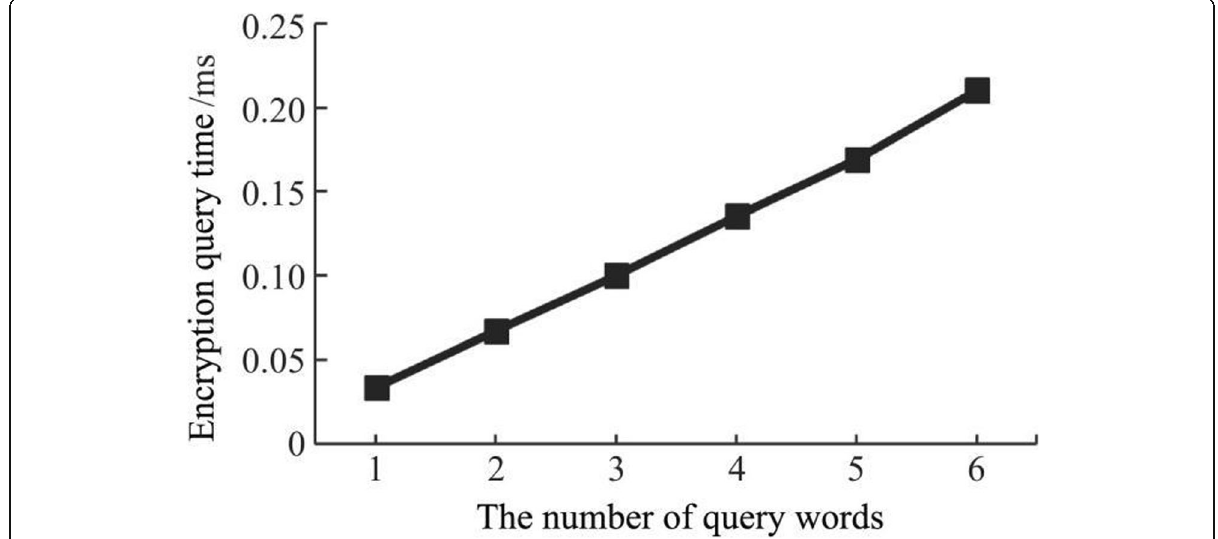
Fig. 14 Time of encrypting